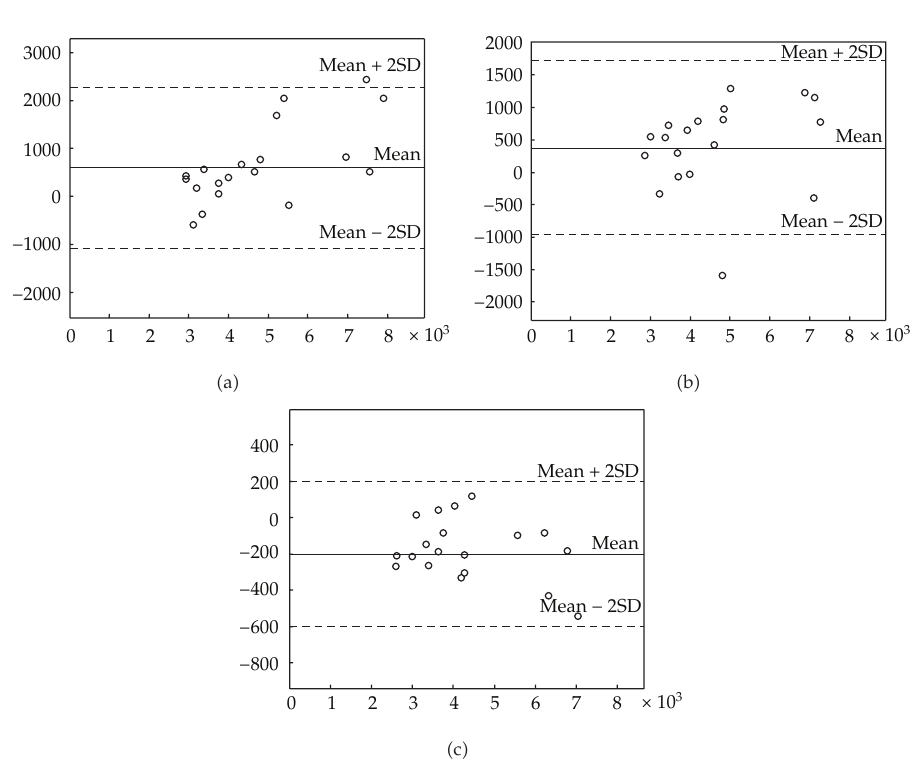
Figure 13: Bland-Altman plots for the comparison of the tumor areas on clinical US images of breast tumors, assessed by three segmentation models and by the golden standard: (cid:3) a (cid:4) GAC (cid:5) 11 (cid:6) , (cid:3) b (cid:4) DRLSE (cid:5) 16 (cid:6) , and (cid:3) c (cid:4) the proposed PGBLSE